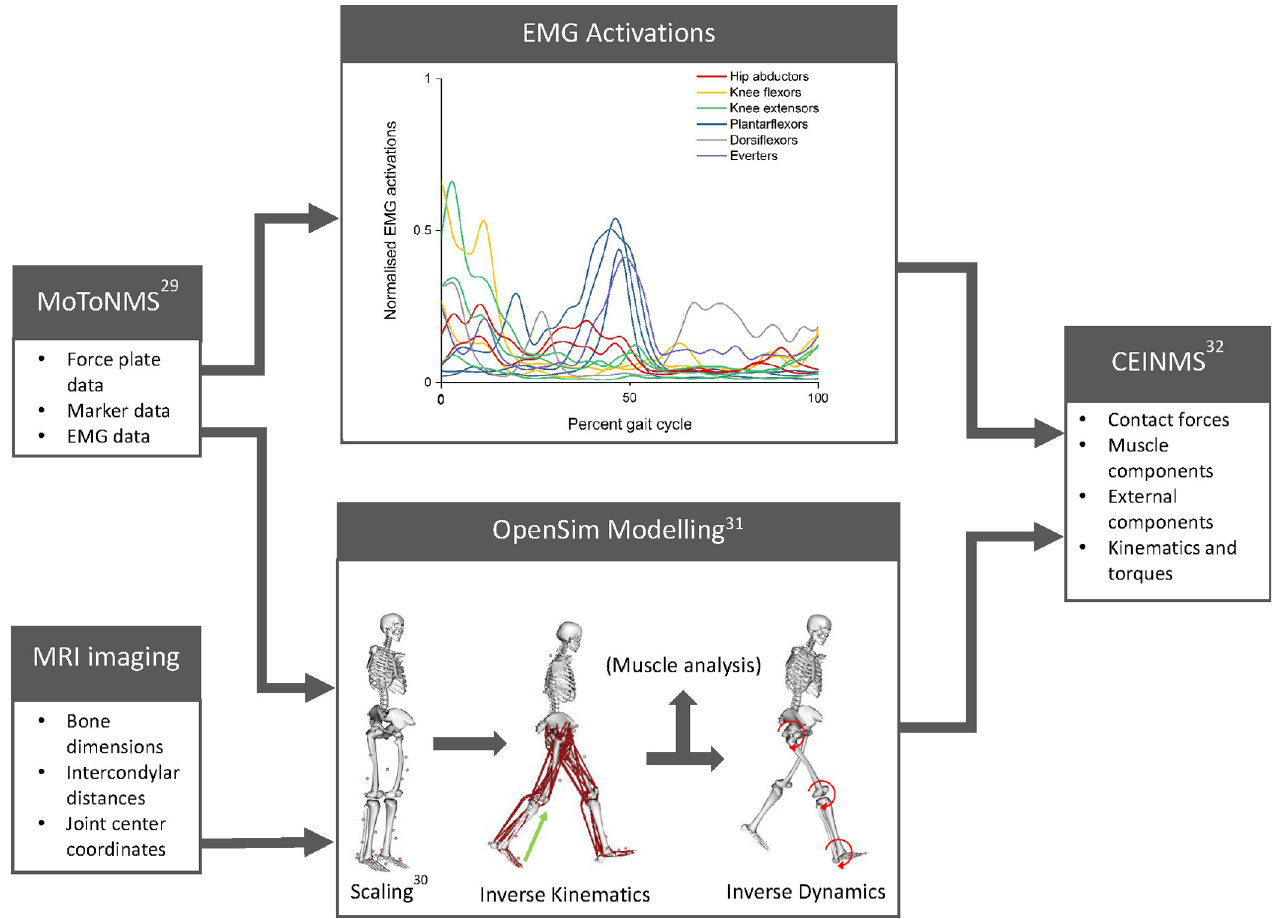
Fig 2. Flowchart outlining the data processing